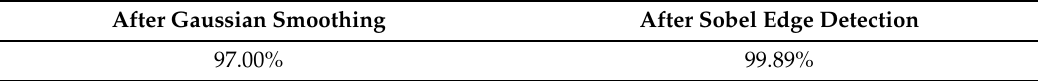
Table 1. Influence of the integer Gaussian kernel on the accuracy of smoothing and edge detection results in comparison with the original kernel in floating-point double